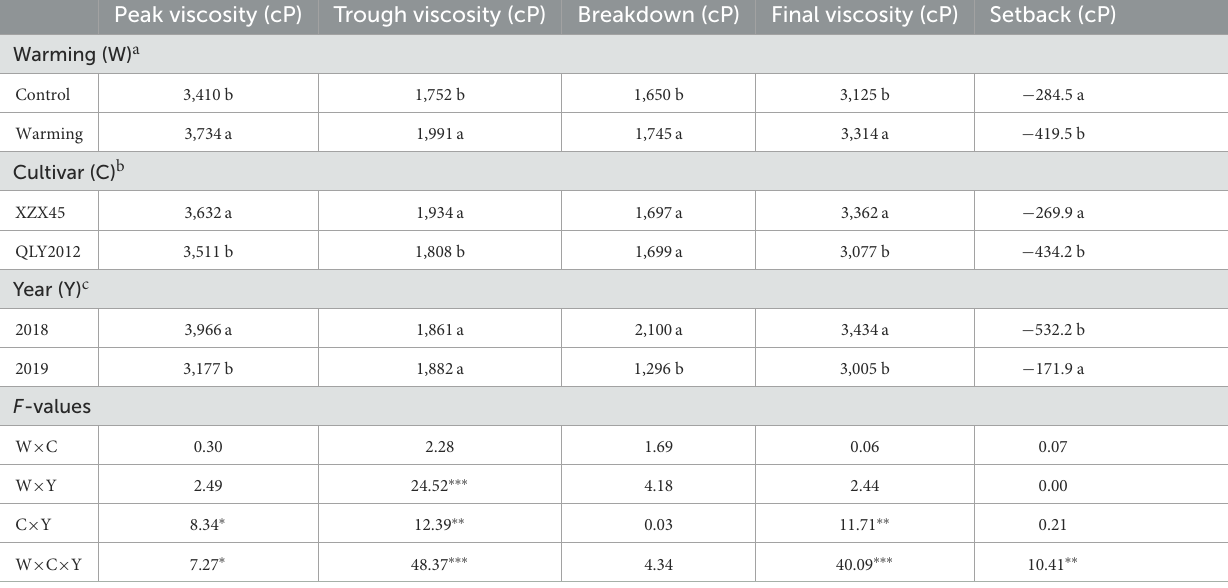
TABLE 5 Rapid viscosity analyzer (RVA) parameters for milled rice as affected by warming, cultivar, and study year. Peak viscosity (cP) Trough viscosity (cP) Breakdown (cP) Final viscosity (cP) Setback